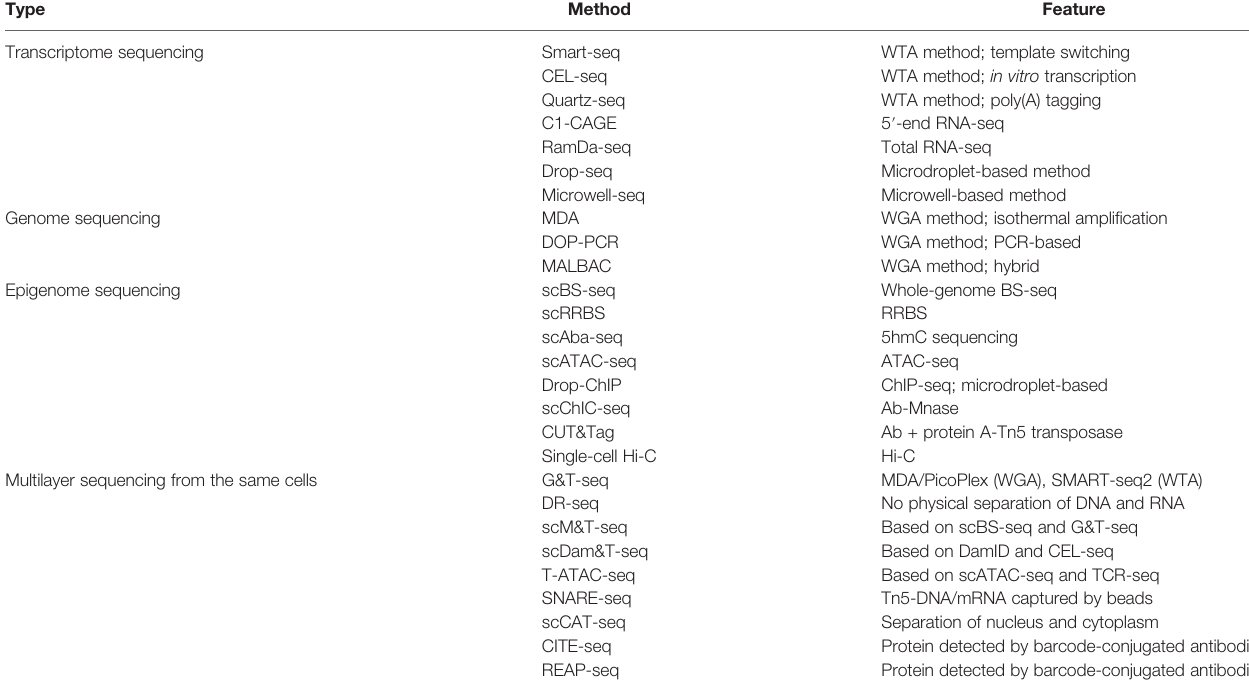
TABLE 1 | Summary of single-cell sequencing applications and methods.